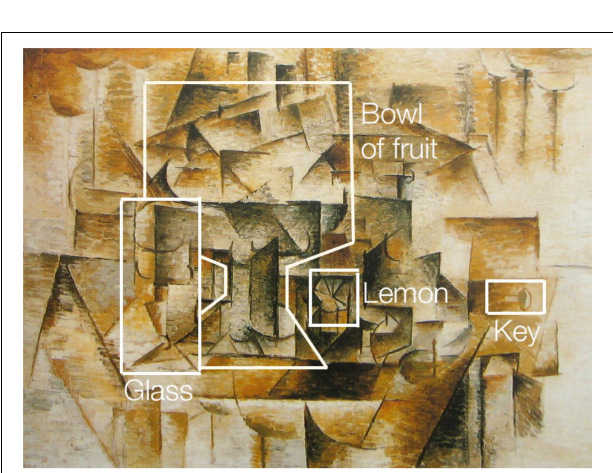
FIGURE 2 | A reproduction of Still Life with Lemons by Pablo Picasso from 1910 with outlined and labelled objects. The painting depicts a table containing a number of everyday household items, including glasses, a fruit bowl, a lemon, and a key. The edges and legs of the table can be seen to the left and right of the central grouping of